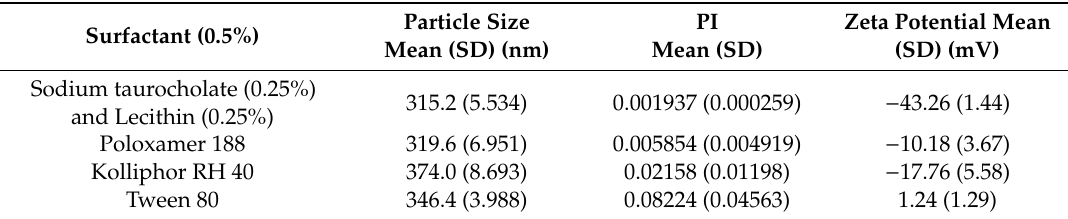
Table 1. Particle size and zeta potential of surfactant systems; data presented as mean (standard deviation), N = 3.